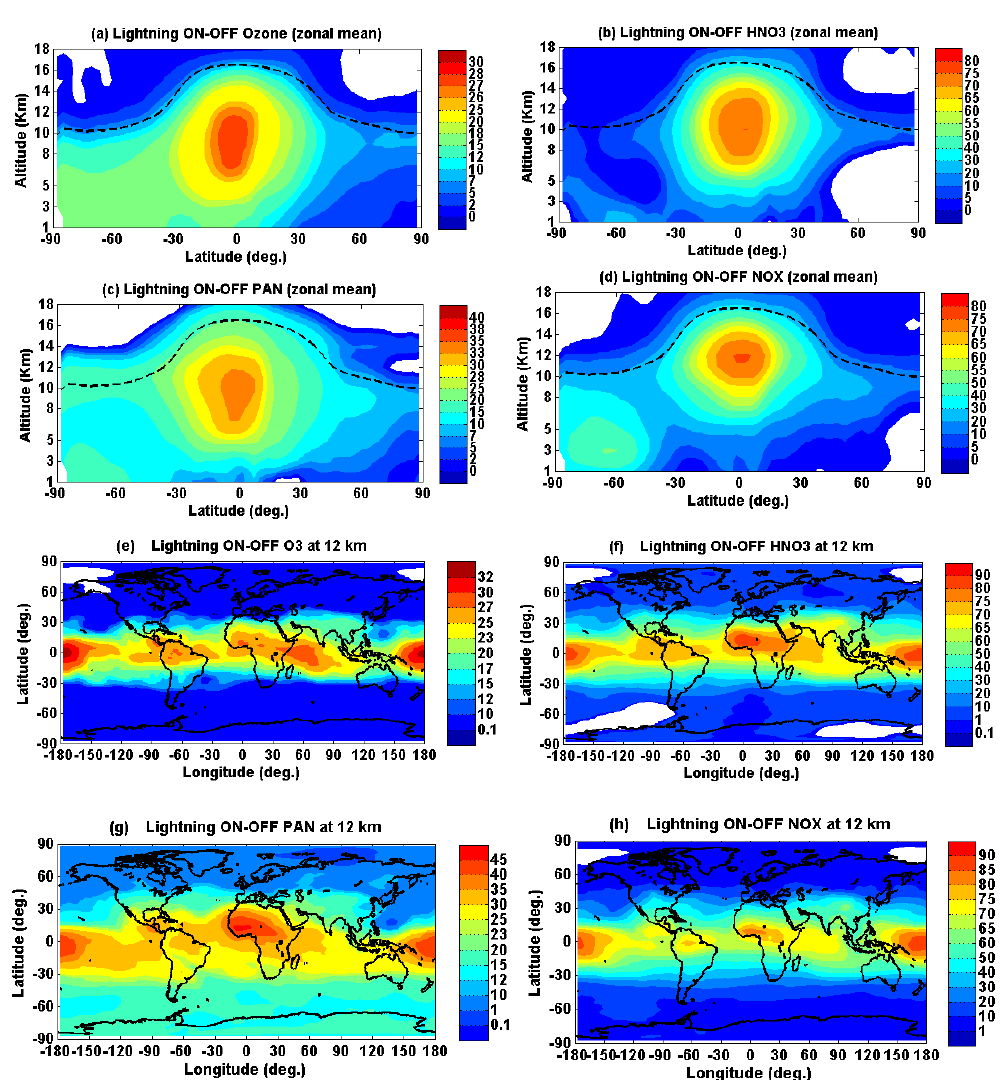
Figure 11. Zonal averaged seasonal mean changes (percentage) produced from lightning in (a) ozone (b) HNO 3 (c) PAN and (d) NO x ; distribution of seasonal mean changes (percentage) produced from lightning in (e) ozone (f) HNO 3 (g) PAN and (h) NO x at